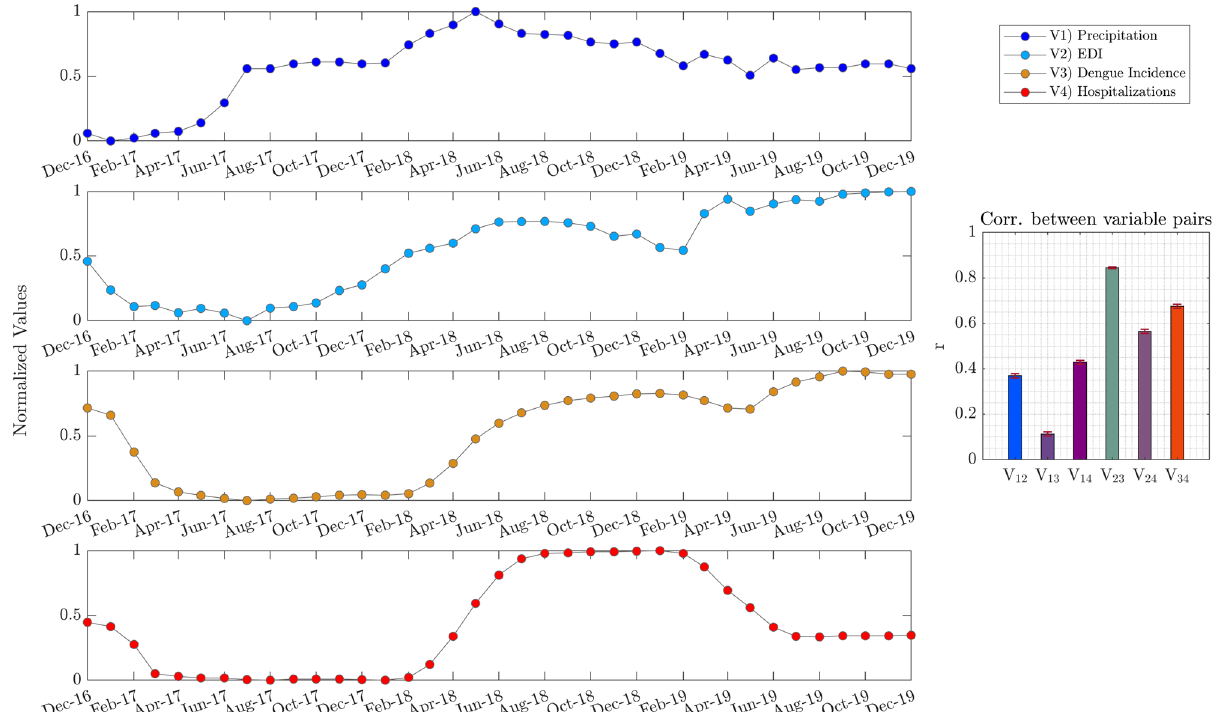
Figure 6. Accumulated values for 1-year sliding windows and their pairwise relations. The time series represents the normalized values (0–1 scaling) of the Precipitation, EDI, Dengue Incidence, and Hospitalizations, each colored differently. The right panel represents a pairwise similarity between the analyzed variables; the similarity was estimated by computing the correlation coefficient between samples selected randomly (100 times); the bar height represents mean values, and whiskers represent standard